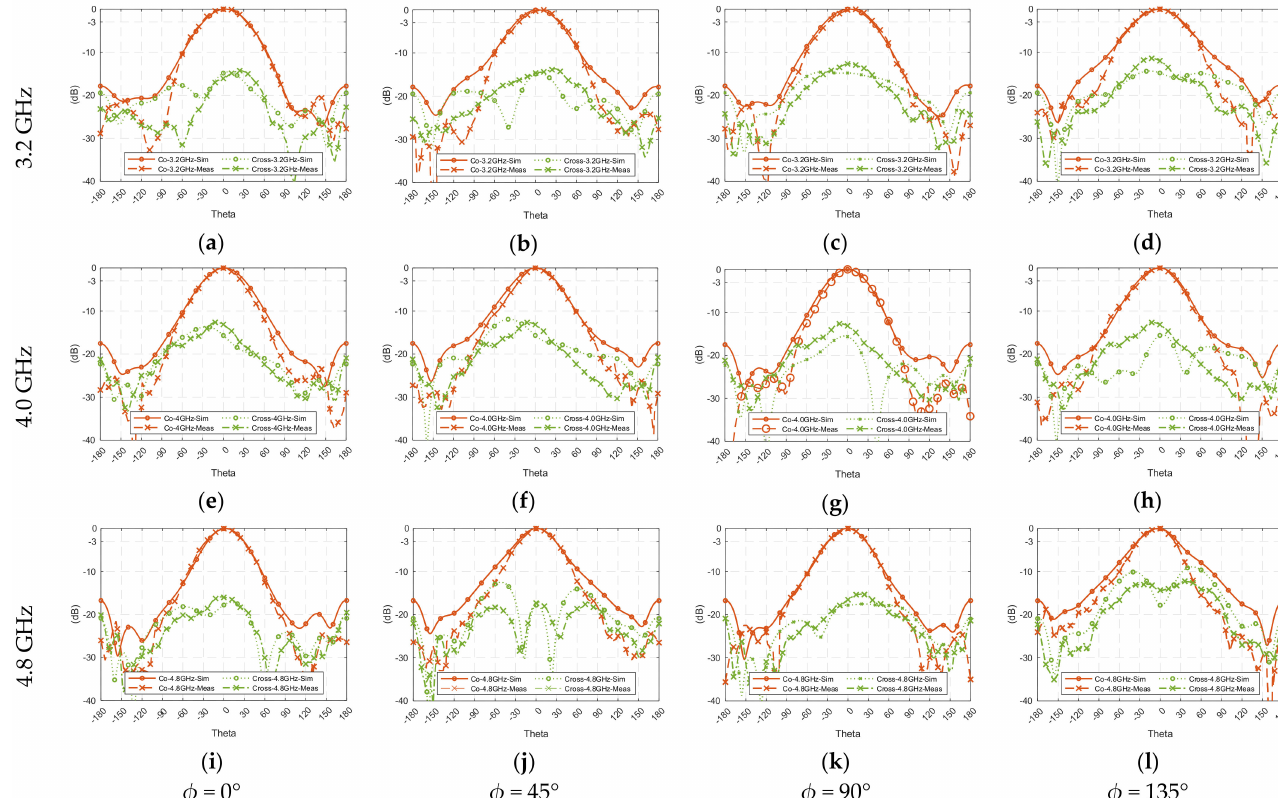
Figure 13. Radiation patterns of the proposed antenna, ( a – d ) at 3.2 GHz, ( e – h ) at 4 GHz, and ( i – l ) at 4.8 GHz, in the four principal planes: φ = 0 ◦ , 45 ◦ , 90 ◦ , and 135 ◦